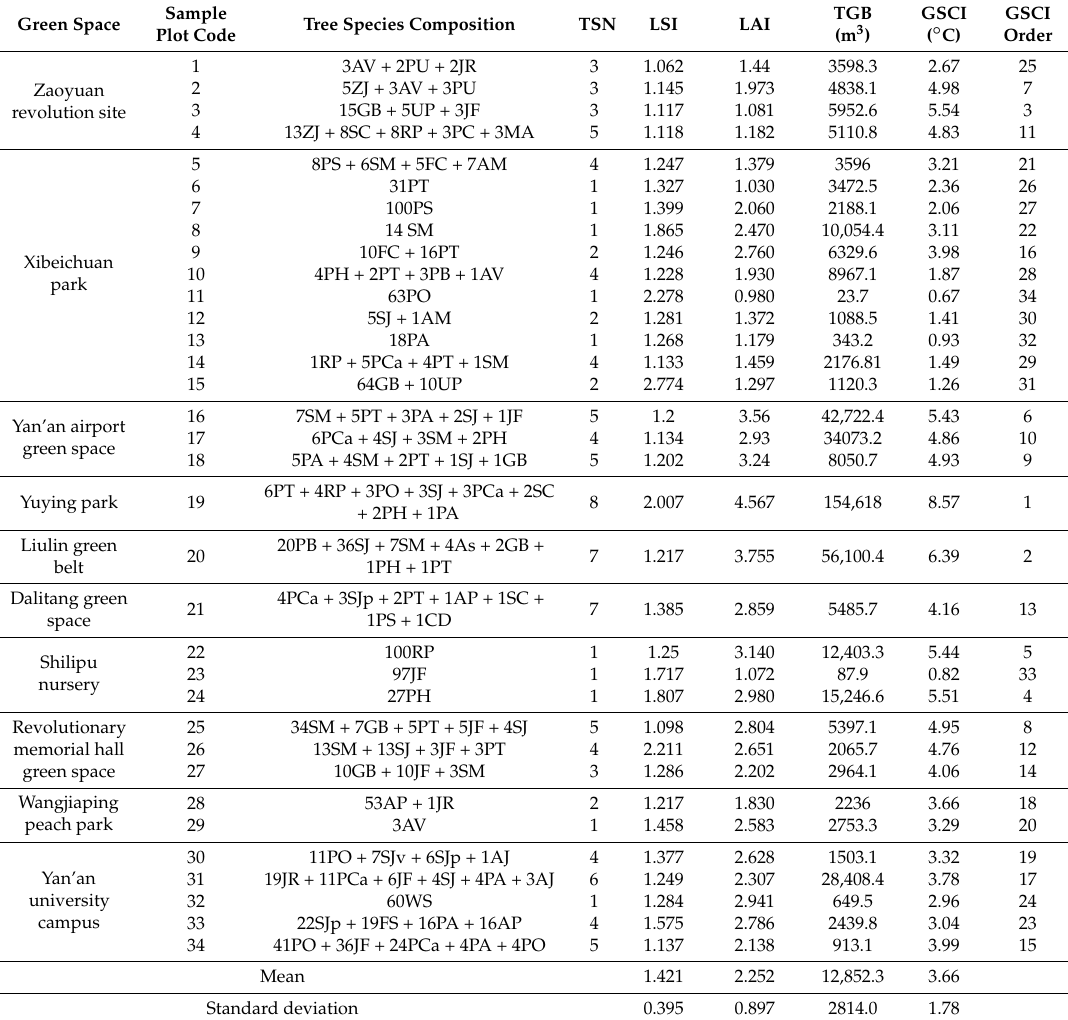
Table 6. Descriptive statistics for the size, GSCI and number of plots for each urban green space. Green